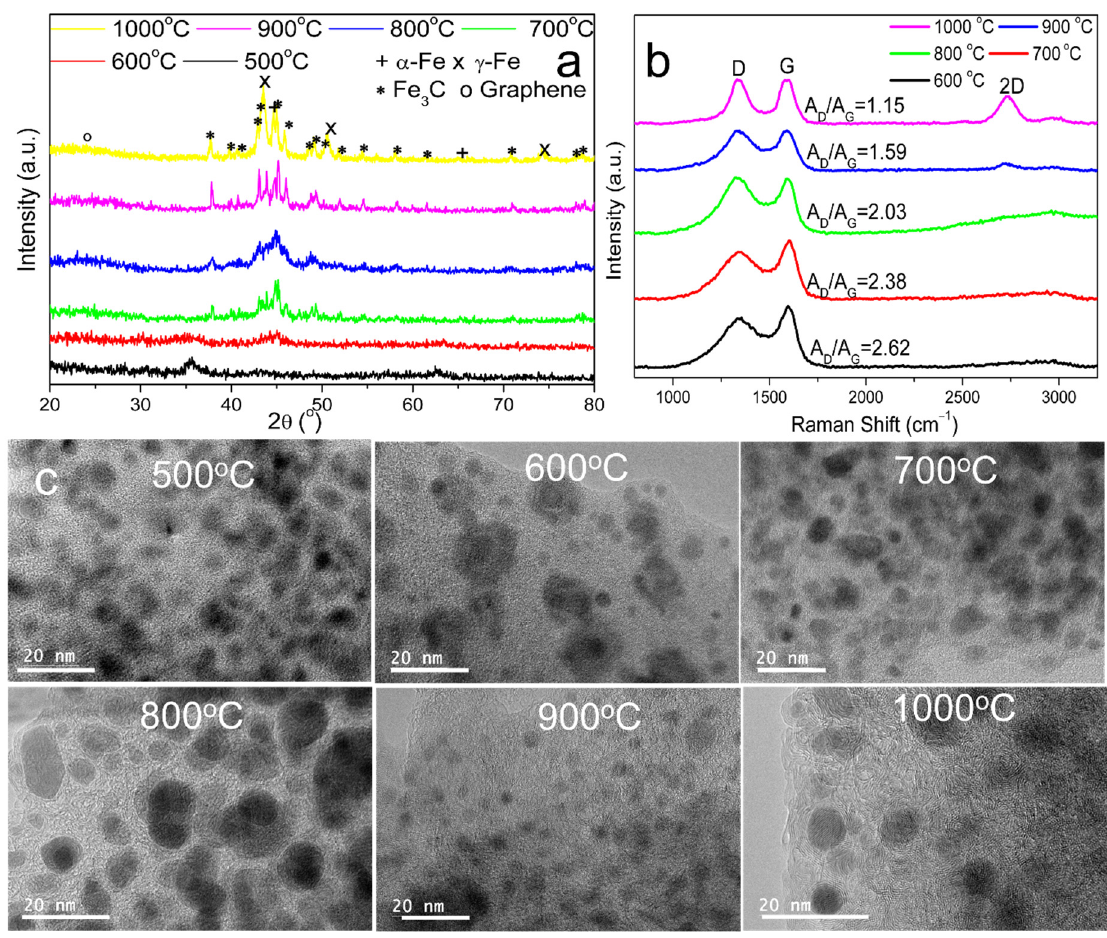
Figure 2. X-ray diffraction (XRD) patterns ( a ), Raman spectra ( b ), and HRTEM images ( c ) of Fe-lignin nanocomposites catalytically graphitized under argon atmosphere at different temperatures: 500 °C, 600 °C, 700 °C, 800 °C, 900 °C, and 1000 °C.